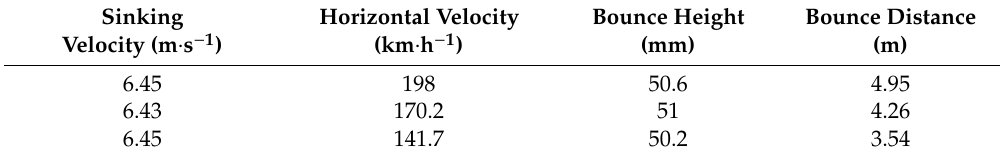
Table 5. Test result of bounce height and bounce distance with different horizontal velocity.